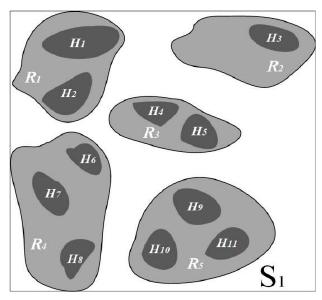
Figure 6. Complex holed-region entity scene S 1 .